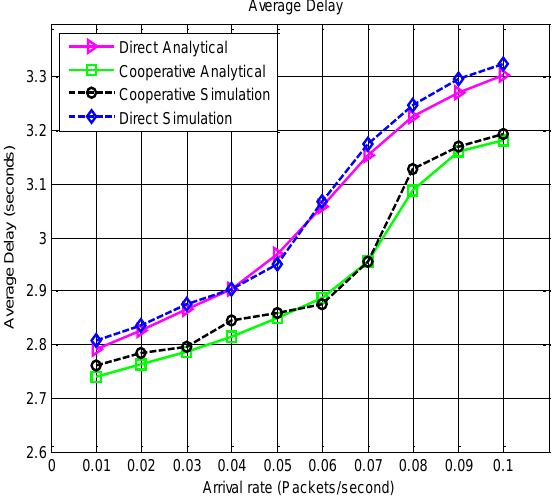
Figure 15. Average end to end delay vs. arrival